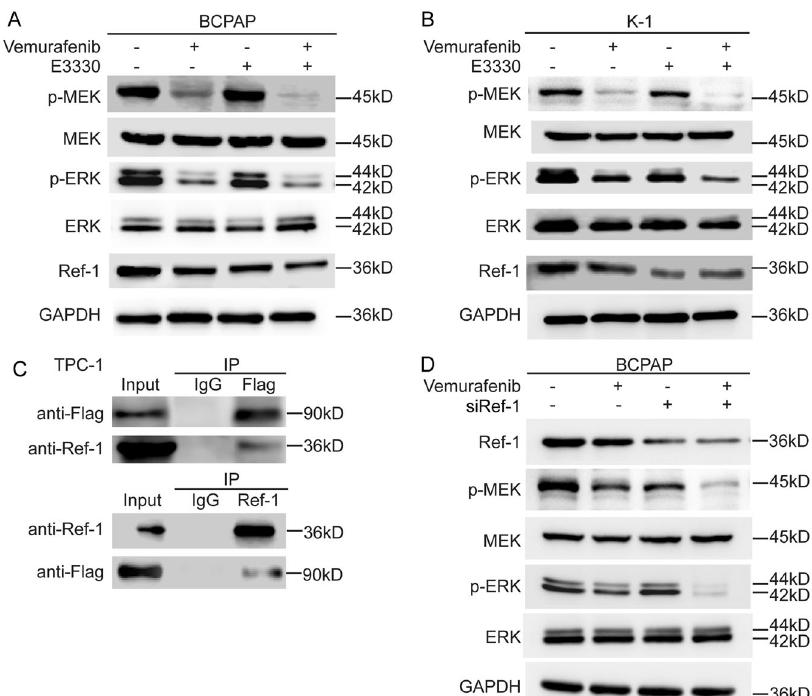
Fig. 5 Ref-1 promoted the maintenance of mutant BRAF function. A , B Western blot detection of MAPK pathway activation in DMSO, vemurafenib (10 μ M), E3330 (50 μ M), and combination (10 μ M vemurafenib + 50 μ M E3330) groups. C The mode of action of Ref-1 and BRAF determination by a Co-IP assay using TPC-1 cells with a BRAF V600E Tet-on system. D MAPK pathway activation detection by western blot assay after small interfering RNA targeting of Ref-1 with vemurafenib